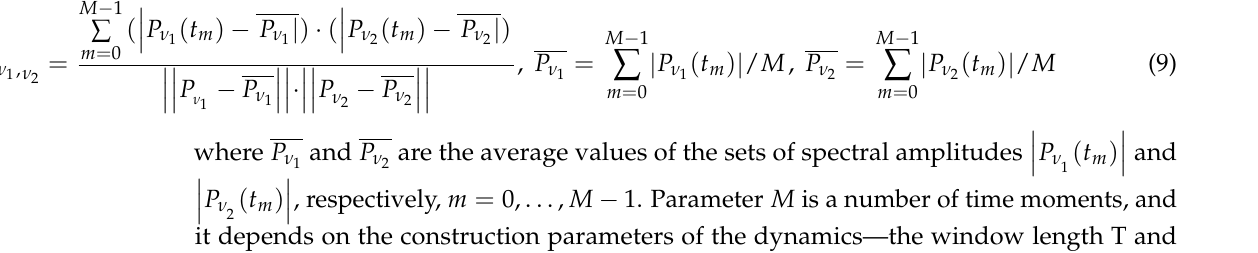
= . We see that the spectral maxima of the transmitted signal coincide